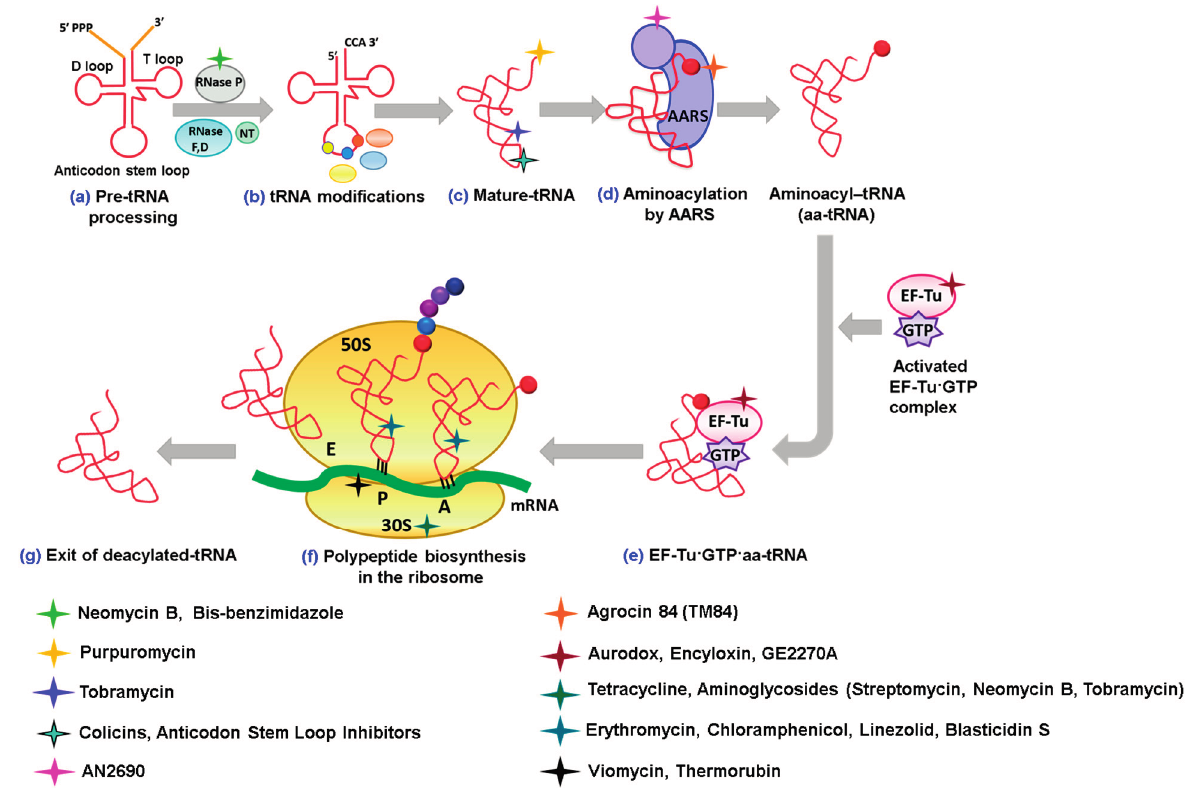
Figure 1. Stages of tRNA biology and protein biosynthesis in bacteria targeted by antibiotics. ( a ) Pre-tRNA transcripts are first processed by ribonucleases (RNase) E or F at the 3'-end, followed by RNase D. Similarly, the 5'-leader sequence is acted upon by RNase P, which is followed by nucleotidyl transferases (NT) for addition of CCA at the 3'-trailer sequence; ( b ) Modification of certain bases takes place using tRNA modification enzymes (mostly in the anticodon stem loop domain) to produce ( c ) the mature tRNA; ( d ) Aminoacyl-tRNA synthetases add amino acids to the cognate tRNA at the CCA 3'-end; ( e ) Activated EF-Tu·GTP complex recognizes the aminoacylated tRNA and transports it to the A-site on the 30S ribosomal subunit; ( f ) Once assembly of the mRNA, fMet-tRNA Met and 50S subunit is complete, the peptidyl transferase reaction starts and initiates the building of the polypeptide chain. Once the ribosome encounters a stop codon, the addition of amino acids to the polypeptide chain halts and the complete polypeptide chain is released; and ( g ) Deacylated tRNA then